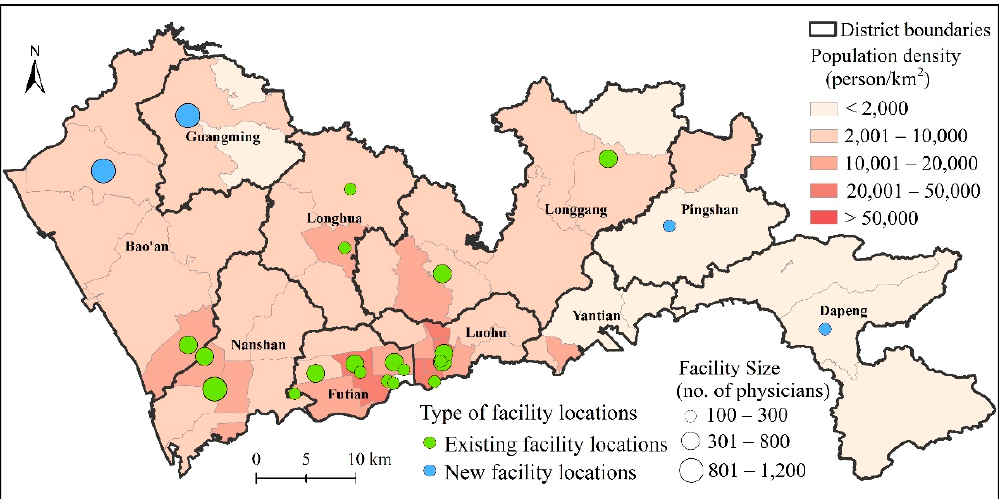
Figure 4. Optimized distribution of tertiary healthcare facilities.